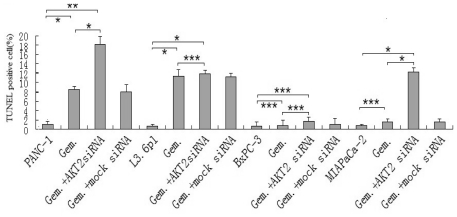
Effect of rAAV2-AKT2 siRNA in combination with gemcitabine on tumor growth. TUNEL analysis of apoptotic cells. Resutls shown as mean ± SEM from two independent experiments. * P < 0.05, ** P< 0.01, *** P > 0.05 by Student’s t test.